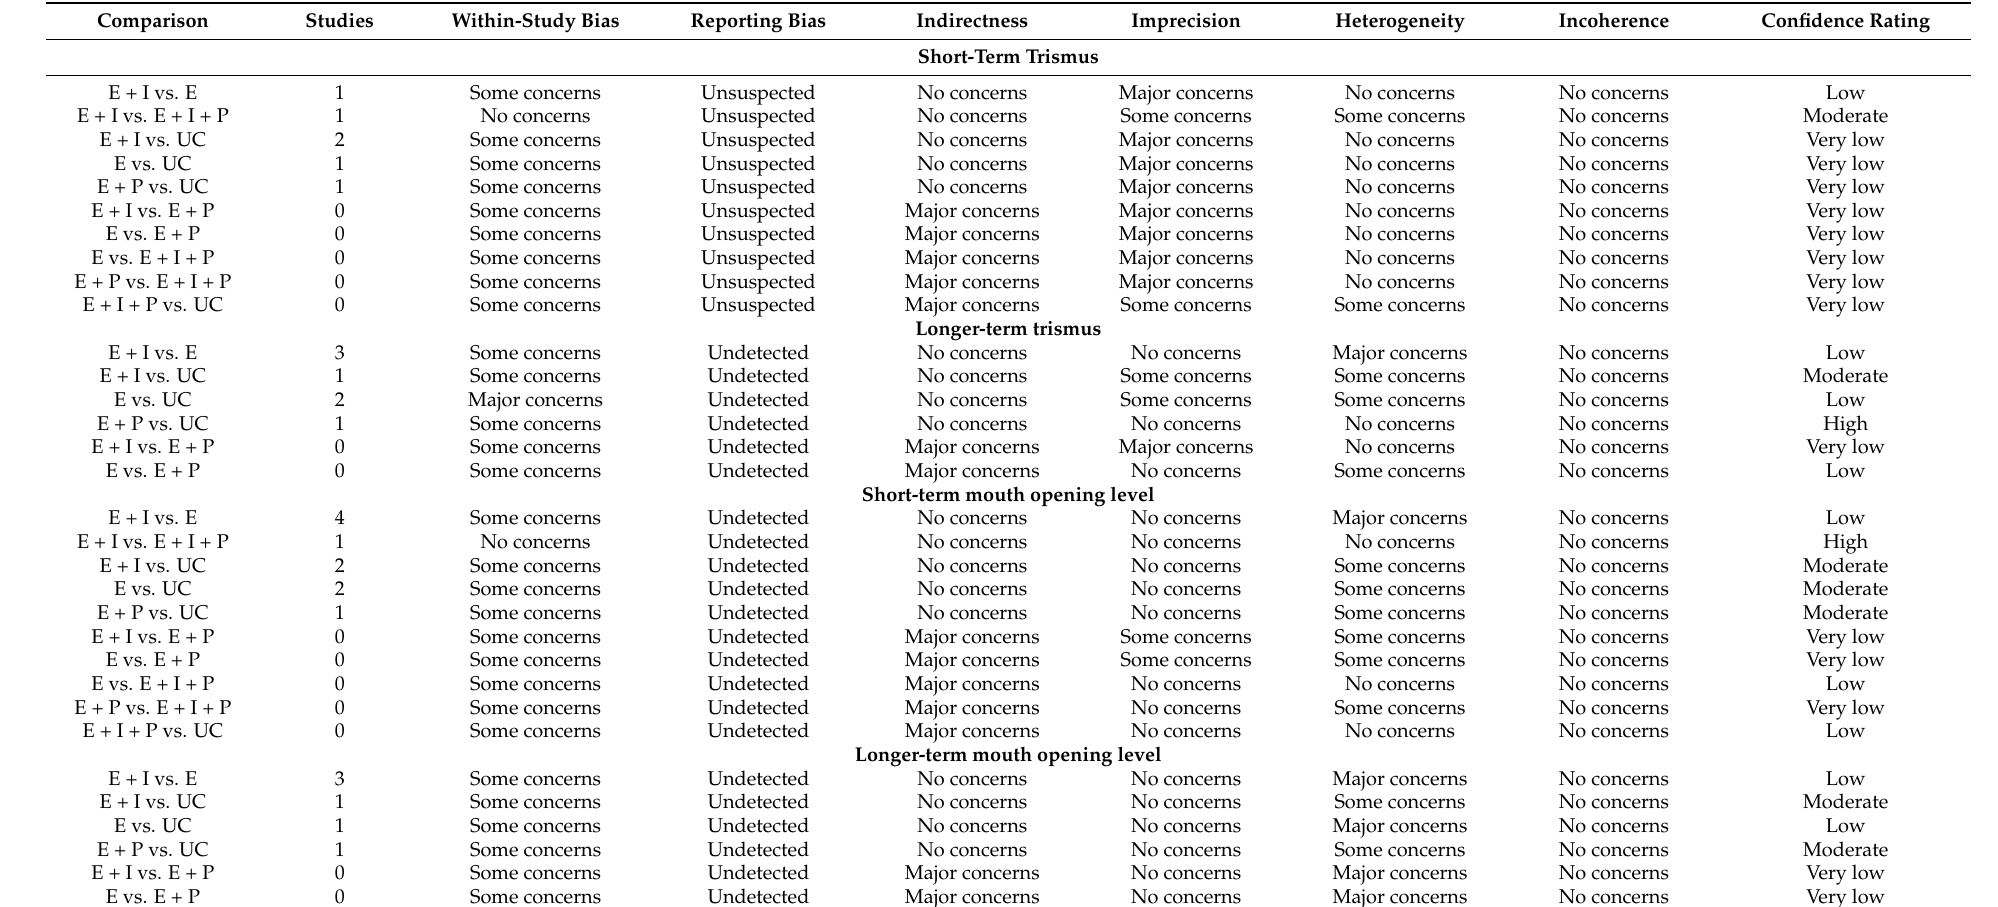
Table 2. Confidence